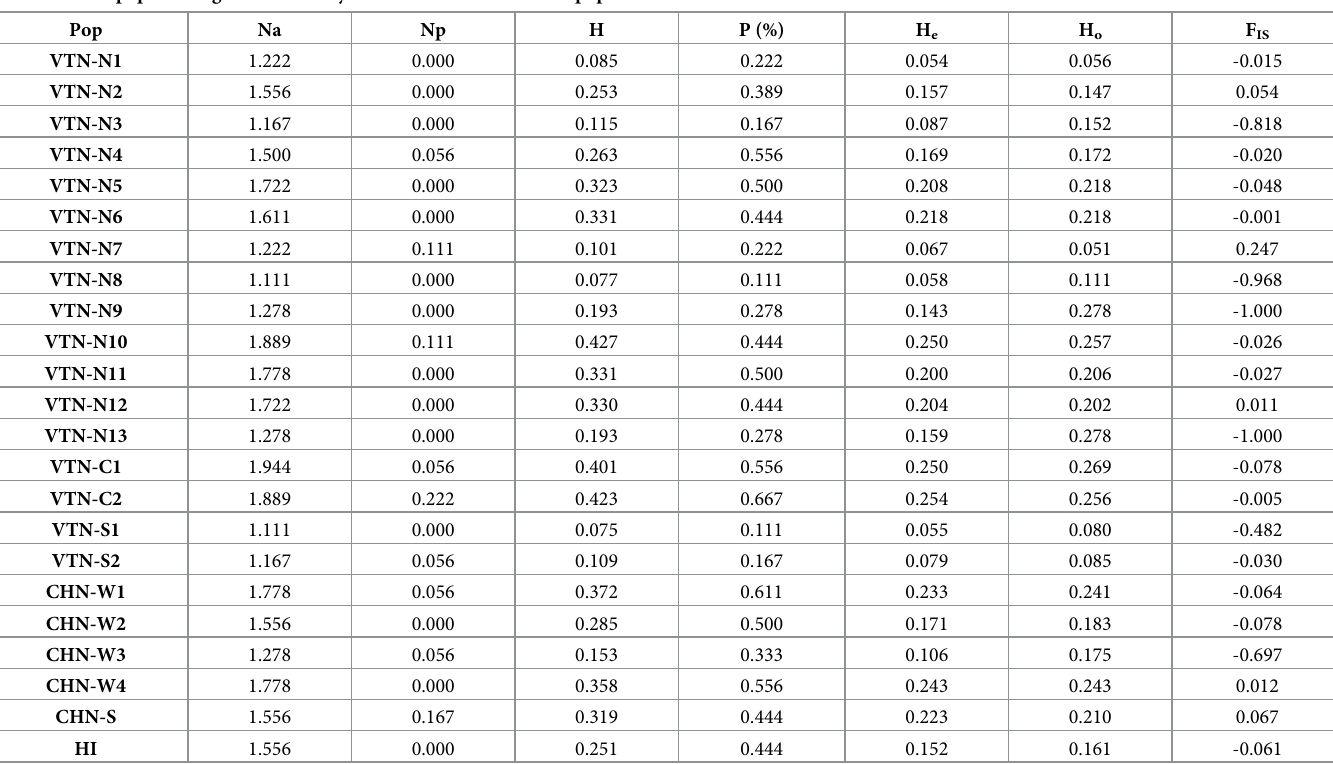
Table 2. Intra-population genetic diversity indices of Musa balbisiana